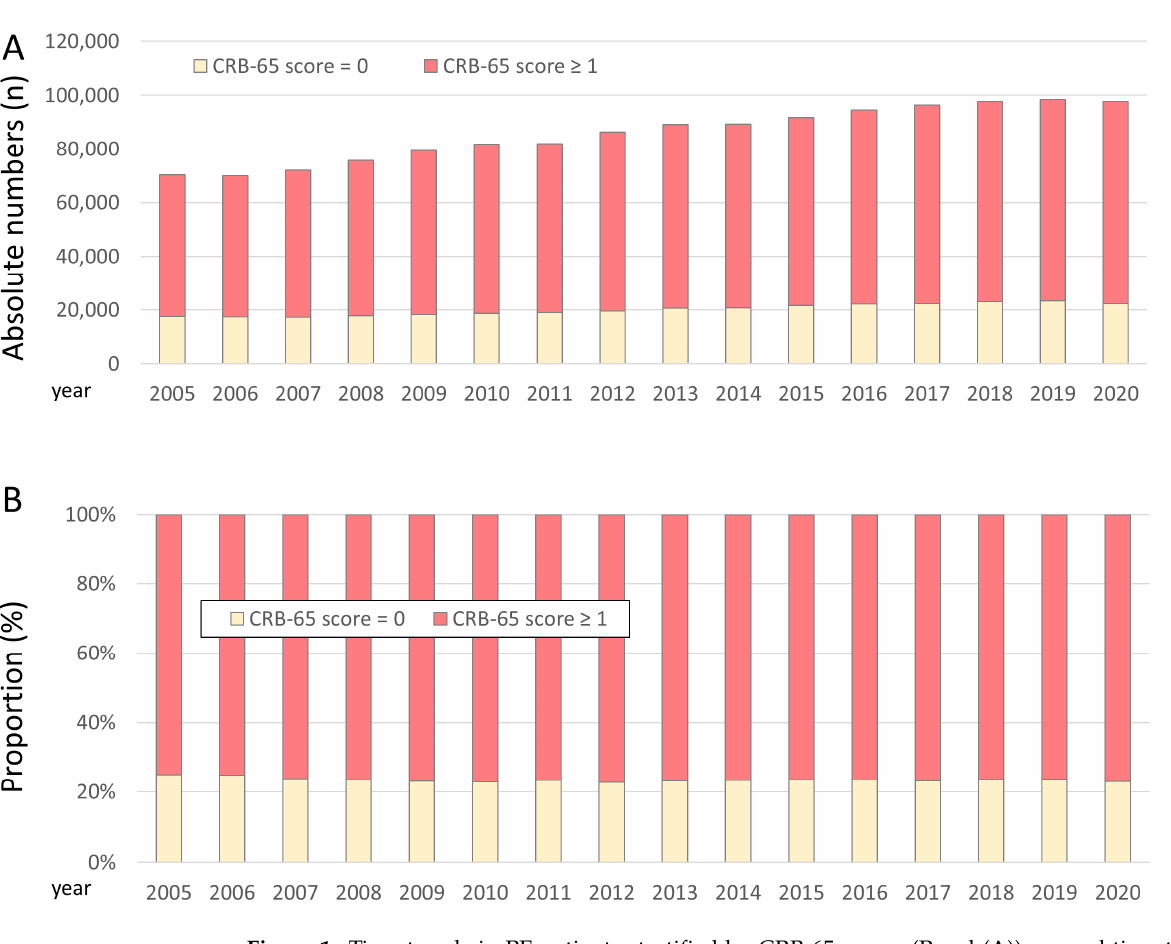
Figure 1. Time trends in PE patients stratified by CRB-65 score. (Panel ( A )): annual time trends re- garding absolute numbers of PE patients stratified by CRB-65 risk class during the observational